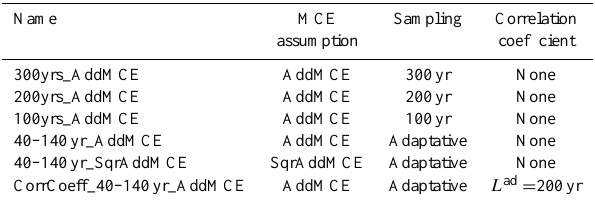
Table 1. Summary of the simulation configurations for the experi- ments of Sect. 2.4.1. Sampling and error correlation